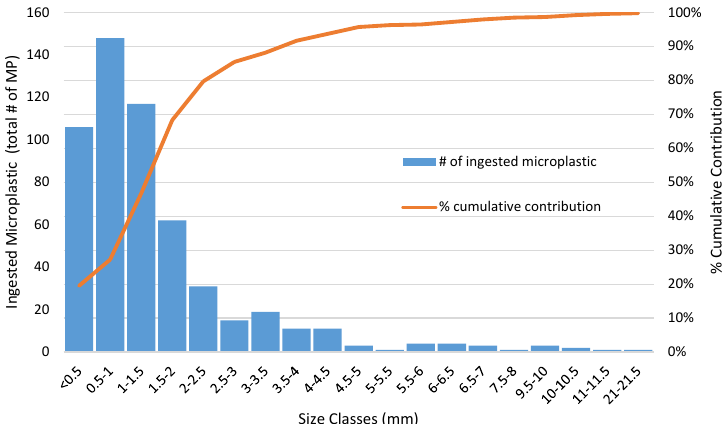
Fig. 4: Frequency of microplastic ingestion with corresponding percent cumulative contribution at various size classes in S. lemuru (n=134)